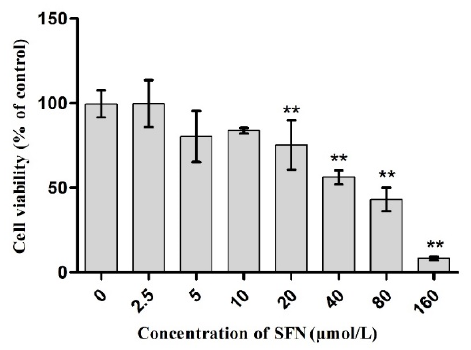
Figure 2. Effect of SFN on the activity of TM4 cells. ** p < 0.01 as compared to the control group.